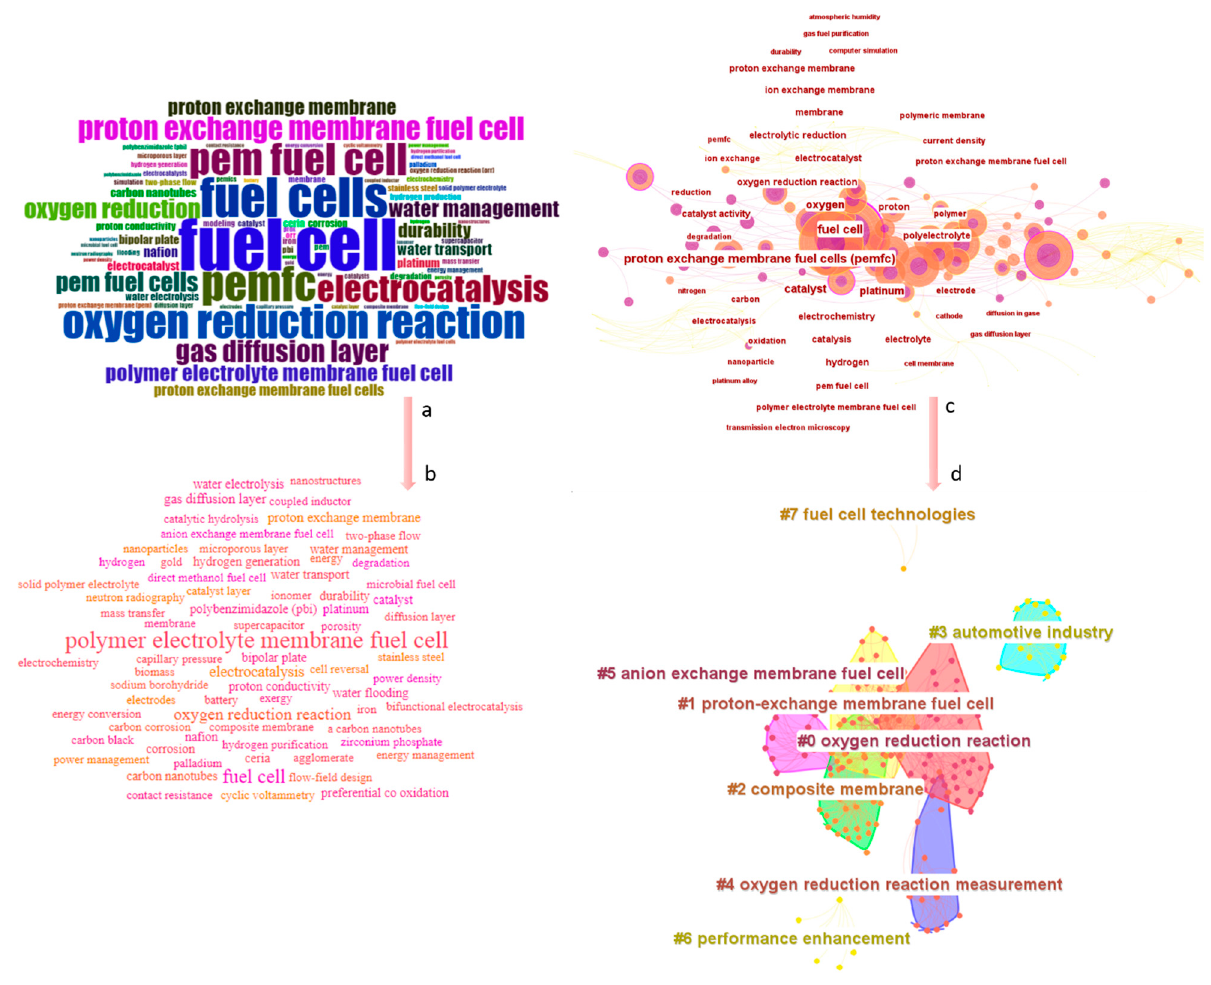
Figure 19. Main research hotspots and frontiers/clusters according to topmost keywords based on the 500 most cited PEMFC articles. ( a ) most used key words ( b ) re-classified key words ( c ) most key words used ( d ) eight main frontiers